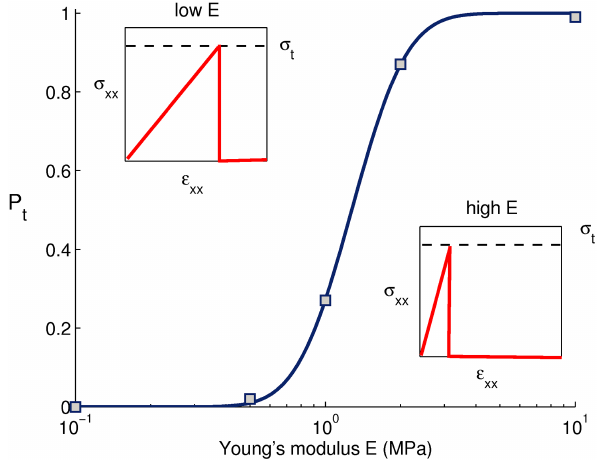
Figure 5. Slab tensile failure probability P t vs. Young’s modulus of the slab for a correlation length (cid:15) = 2m, a slab thickness D = 1m, a slab density ρ = 250kgm − 3 and a tensile strength σ t = 400Pa. The insets show illustrations of the tensile stress σ xx vs. down-slope deformation (cid:15) xx for a low (left) and a high Young’s modulus